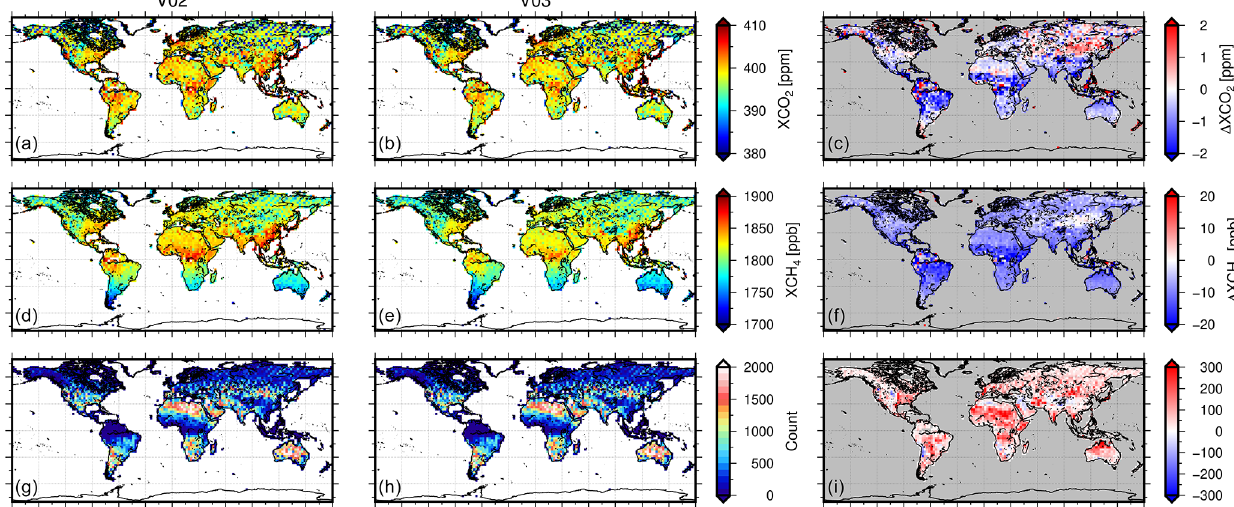
Figure 5. Global distributions of XCO 2 (a–c) , XCH 4 (d–f) , and the number of observations (g–i) for V02.90/91 (a, d, g) , V03.00 (b, e, h) , and their differences (c, f, i) from the launch to 2021 over land and mixed surface. The values are averaged or integrated within 2.5 ◦ × 2.5 ◦ grid boxes. All the observations were used for each version.